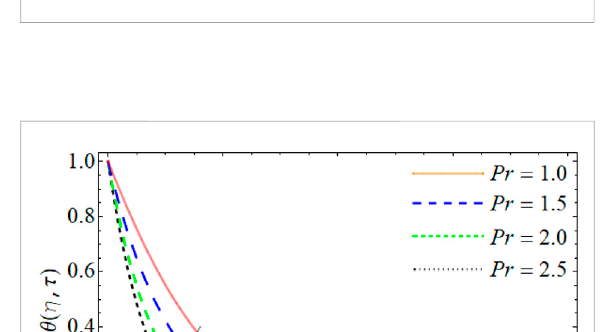
FIGURE 10 Energy outlines θ ( η , τ ) versus thermal radiation N R .